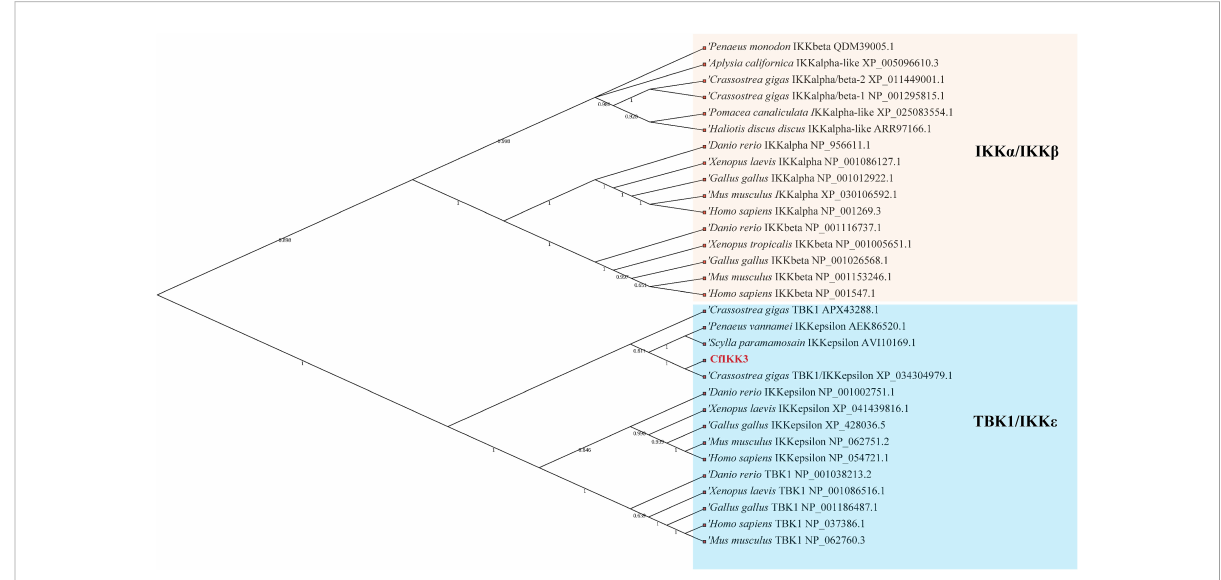
FIGURE 3 Phylogenetic tree of canonical IKKs and IKK-related kinases from various species. The phylogenetic tree was constructed using the neighbor- joining method with 1000 bootstrap replications. The tree is divided into two main branches: IKK a /IKK b family members and TBK1/IKK ϵ family members. The GenBank accession numbers of the protein sequences are also shown.